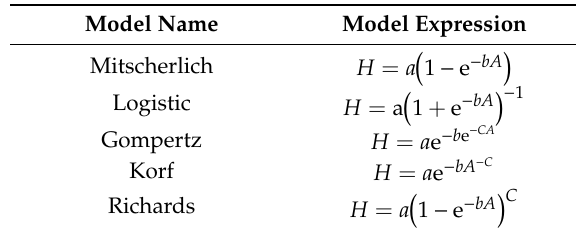
Table 3. Candidate model of site index guidance curve. Mitscherlich, Logistic, Gompertz, Korf, and Richards common growth curve model. a. b, c are fitting parameters, A is age variable, and H is tree